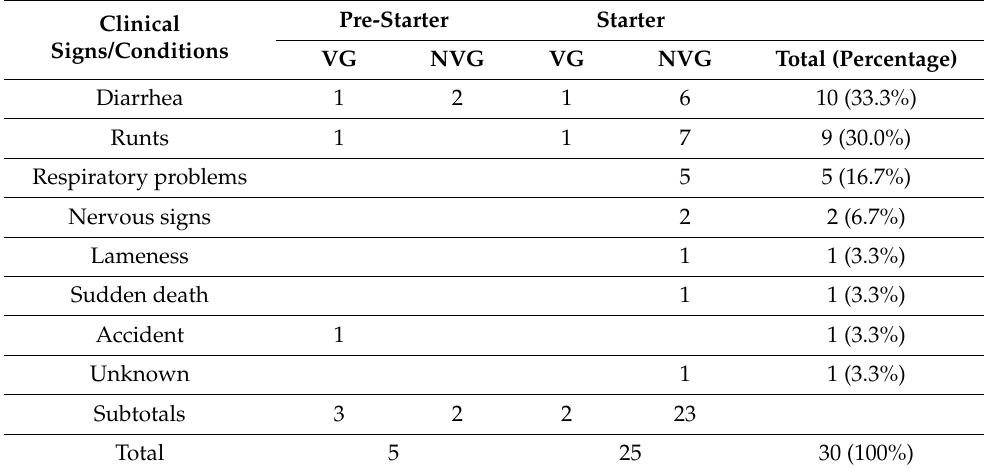
Table 2. Number of piglet losses and major clinical signs associated with them during the nursery in each study group.